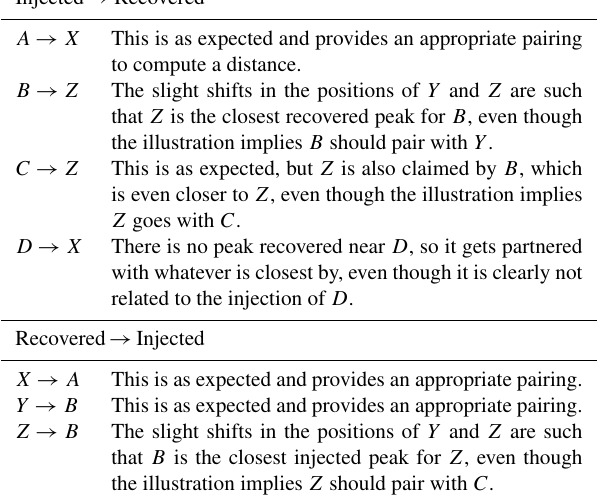
Table A2. Correspondence. This table describes Fig. A1, by listing how each of the injected peaks is mapped to their closest recovered peak. This mapping is also performed in the reverse direction, as correspondence assignment is not